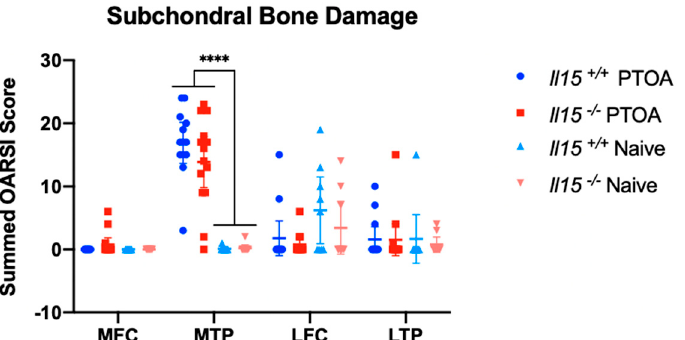
Figure 6. Subchondral bone damage is not significantly different between Il15 +/+ PTOA and Il15 − / − PTOA rats. Rats either underwent ACLT-DMM surgery to induce PTOA or served as a control with no surgery (Naive). Semi-quantitative scoring (scale 0–5) was used to determine the extent of subchondral bone damage in the joint via 4 compartments: medial femoral condyle (MFC), medial tibial plateau (MTP), lateral femoral condyle (LFC), and lateral tibial plateau (LTP). Two-way ANOVA with Tukey’s multiple comparison test was used for statistical analysis; data represents mean with 95% CI. There was no significant difference in summed scores between the Il15 +/+ PTOA and Il15 − / − PTOA groups. The PTOA groups scored significantly higher than the Naive groups only in the MTP.